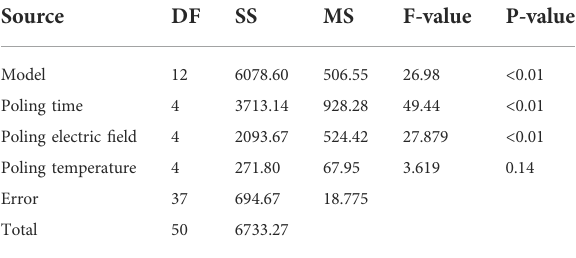
TABLE 1 ANOVA result of the piezoelectric